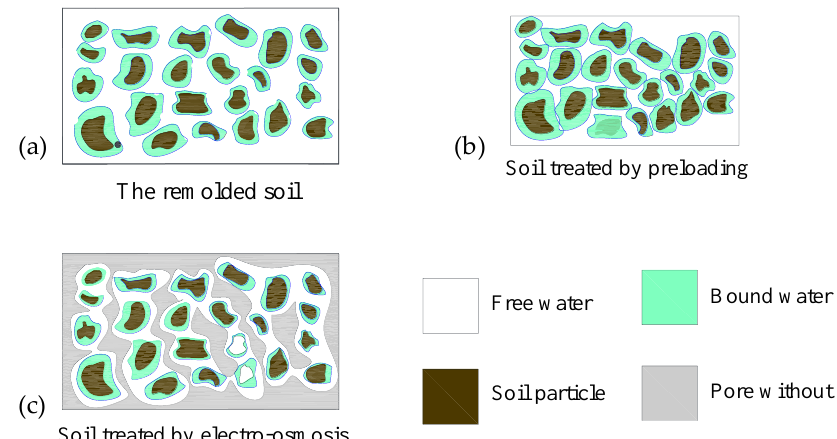
Figure 12. Effects of single electro-osmosis and preloading on the soil pore structure under ideal conditions: ( a ) The remolded soil; ( b ) Soil treated by preloading; ( c ) Soil treated by electro-osmosis.